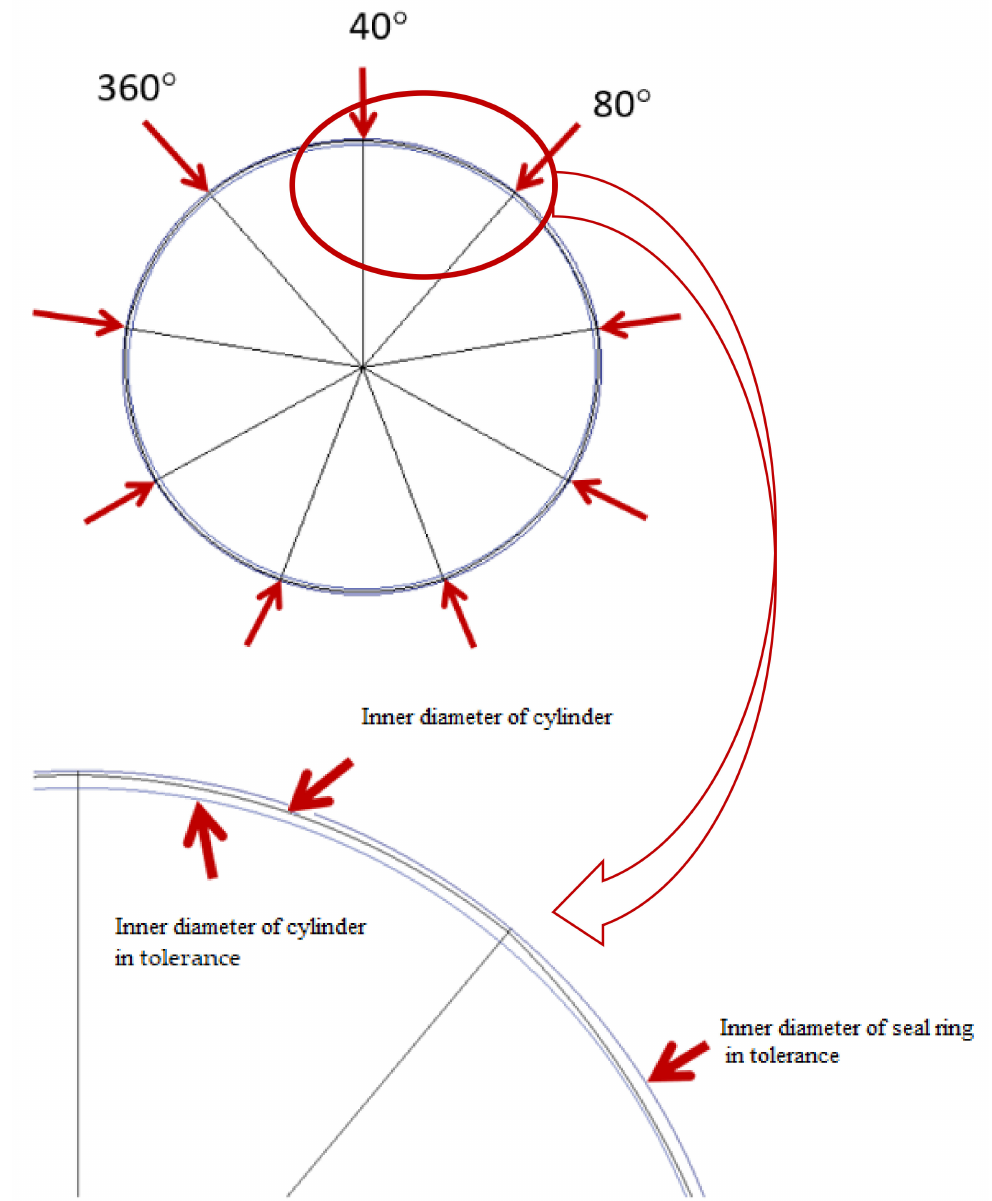
Figure 11. The synergy effects on